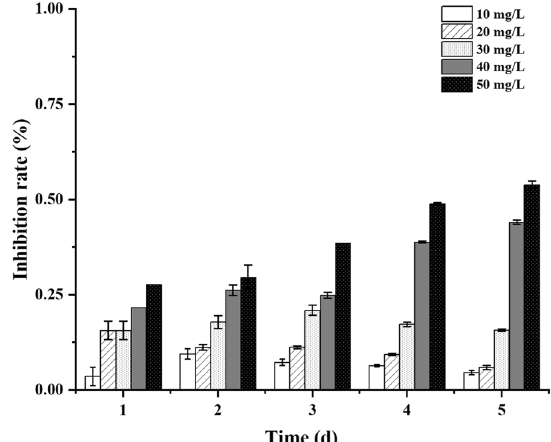
Fig. 1 Inhibitory effects of different concentrations of surfactin on mycelial growth of B. cinerea . The error bars represent the SEs of the three